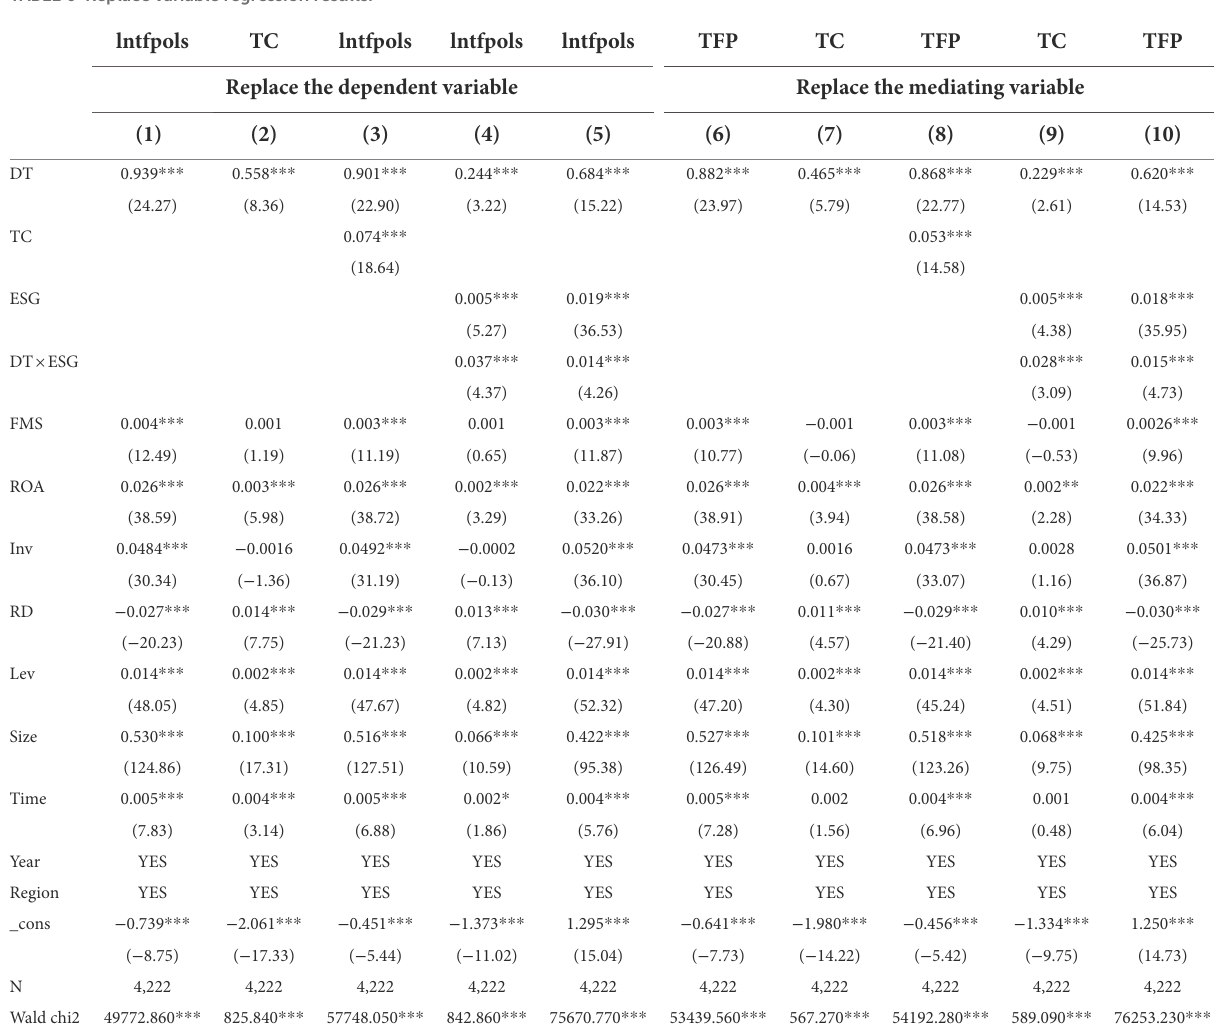
TABLE 6 Replace variable regression